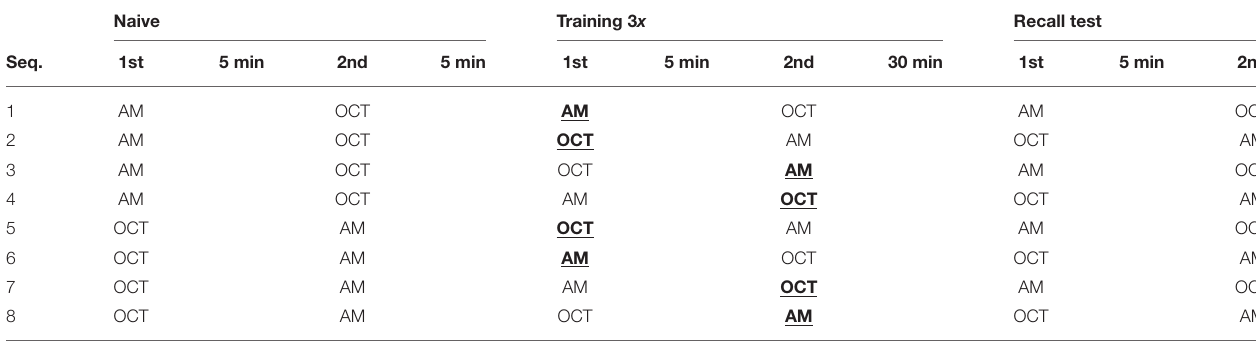
TABLE 4 | Differential olfactory conditioning paradigm. Naive Training 3 x Recall test